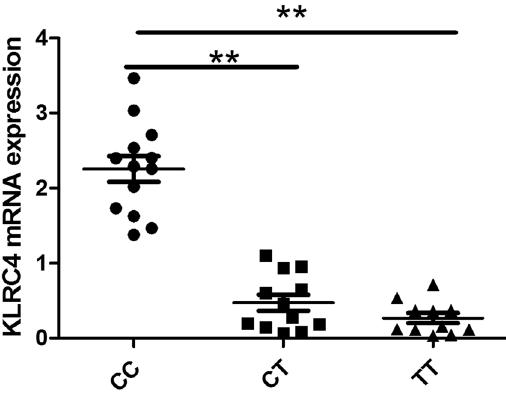
Figure 2. The influence of KLRC4 /rs2617170 genotypes on the expression of KLRC4 in PBMCs. KLRC4 mRNA level in CC individuals of SNP rs2617170 was significantly higher than in CC/CT individuals. Data are shown as